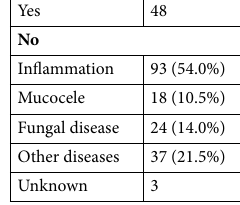
Table 4. Otolaryngology consultation.